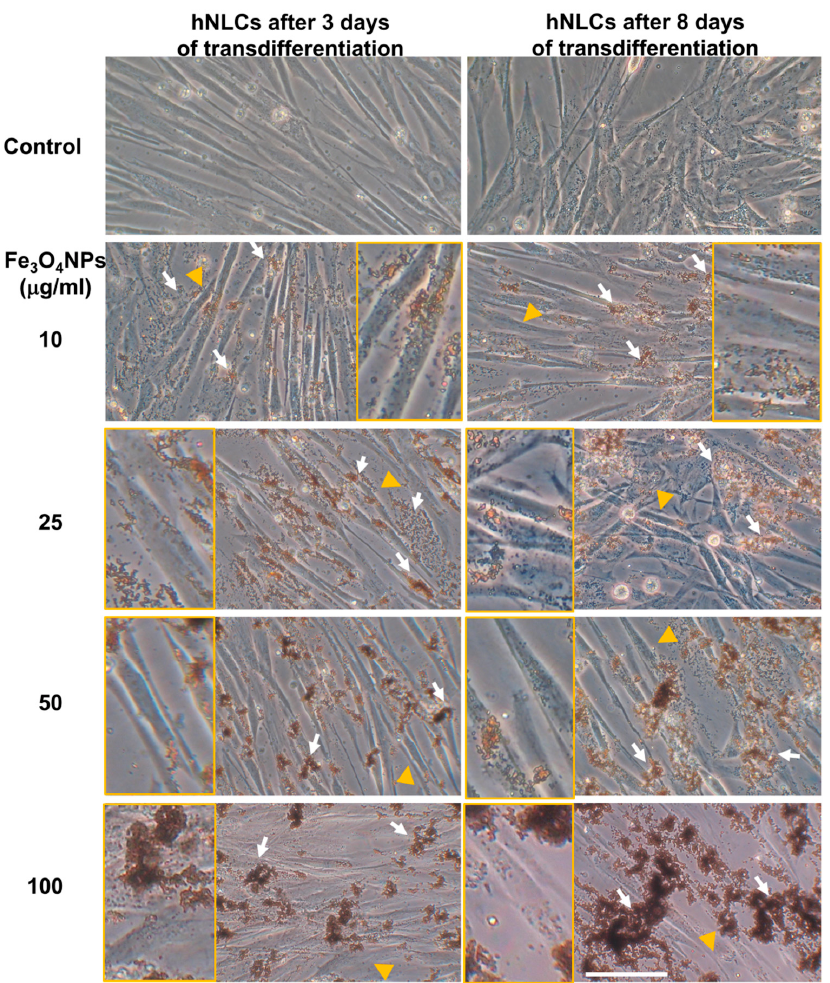
Figure 9. Representative micrographs, by phase-contrast microscopy of early and full transdifferentiated hNLCs after 24 h exposure to increasing Fe 3 O 4 NPs concentrations (10–100 μ g/mL). No morphological alterations were observed after Fe 3 O 4 NPs exposure up to 48 h, however, a cell density decrease was observed from 25 μ g/mL Fe 3 O 4 NPs at both time points considered for both hNLCs. Brownish aggregates/agglomerates of Fe 3 O 4 NPs in culture medium are indicated by white arrows. Inserts show the magnifications (2×) of the areas indicated by the yellow arrowheads where Fe 3 O 4 NPs are visible inside of the hNLCs. Scale bar: 100 μ m. However, cell density decrease was observed from 25 μ g/mL Fe 3 O 4 NPs after 24 and 48 h exposure in both neuron-like cell types. Fine brownish sediments of Fe 3 O 4 NPs were extracellularly visible in both hNLCs at the lowest concentration (10 μ g/mL), which became large aggregates/agglomerates at the higher concentrations